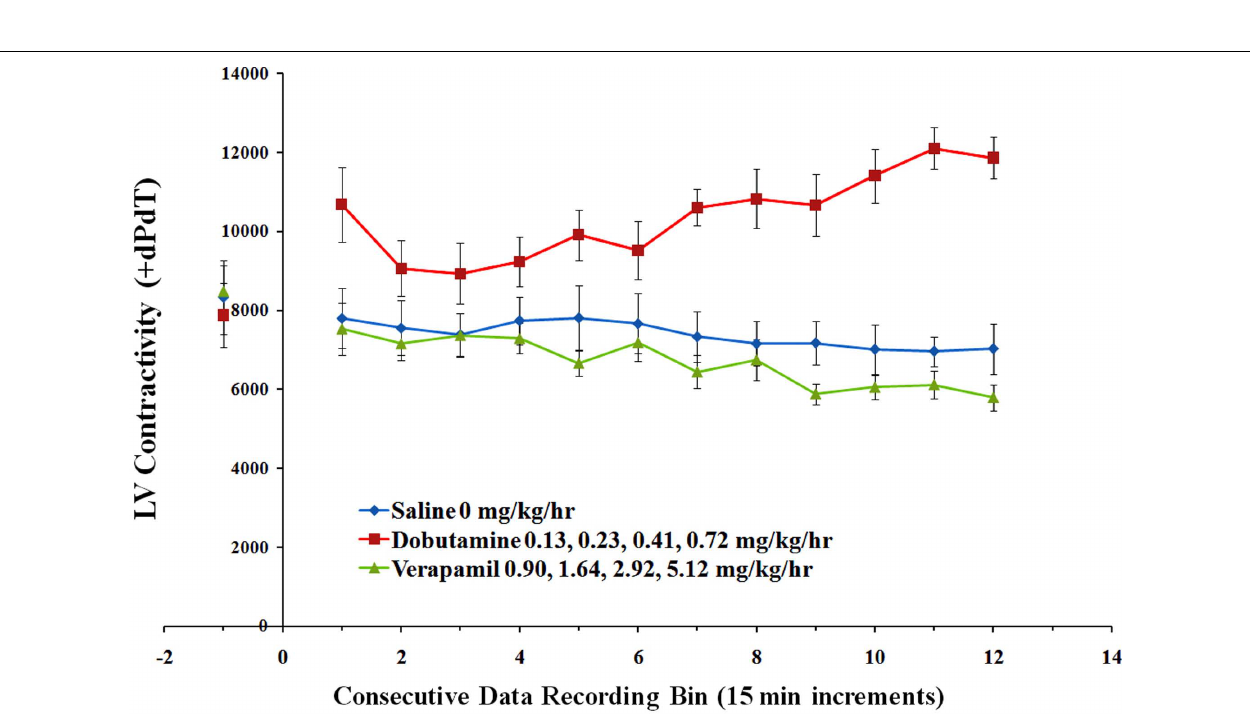
FIGURE 9 | Shows results for LV contractility respectively for the three different treatments. LV contractility was increased by successive doses of dobutamine. LV contractility was decreased by administration of successive doses of verapamil. Points represent means ±